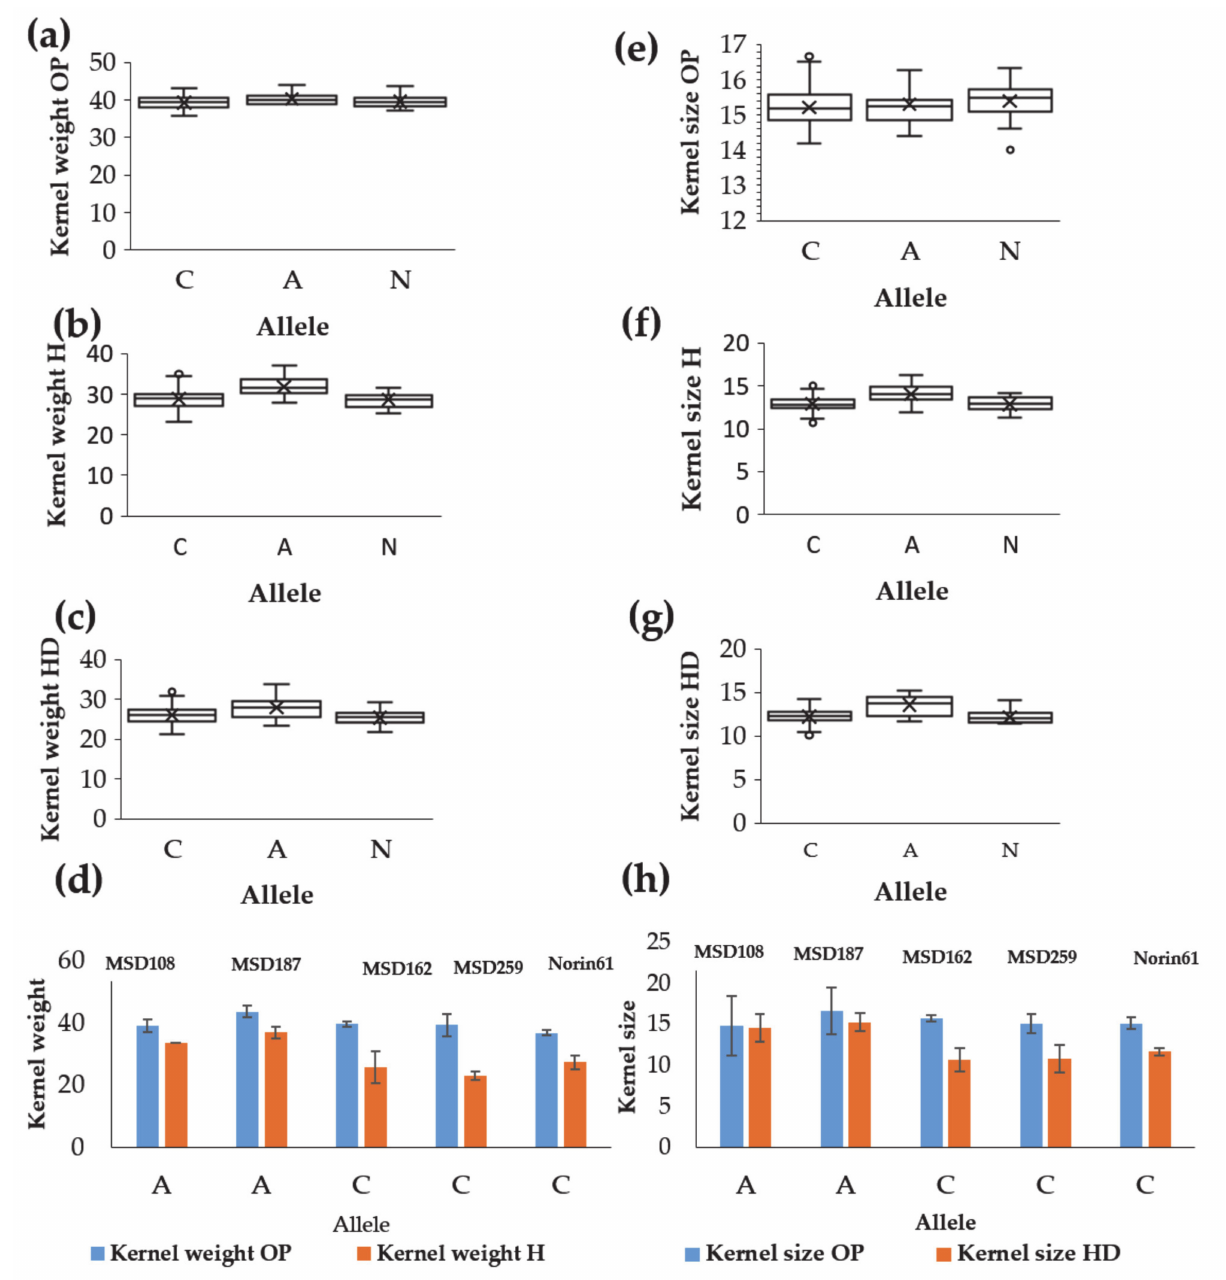
Figure 7. Effects of the alleles of marker 5332404, associated with the kernel weight under heat conditions (H), kernel size under combined heat–drought (HD) conditions and kernel size HD susceptibility index. ( a – c ) Effects on kernel weight under optimum (OP), H and HD conditions; ( e – g ) Effects on kernel size under OP, H and HD conditions. ( d , h ) Effects on kernel weight and kernel size of some MSD lines and Norin